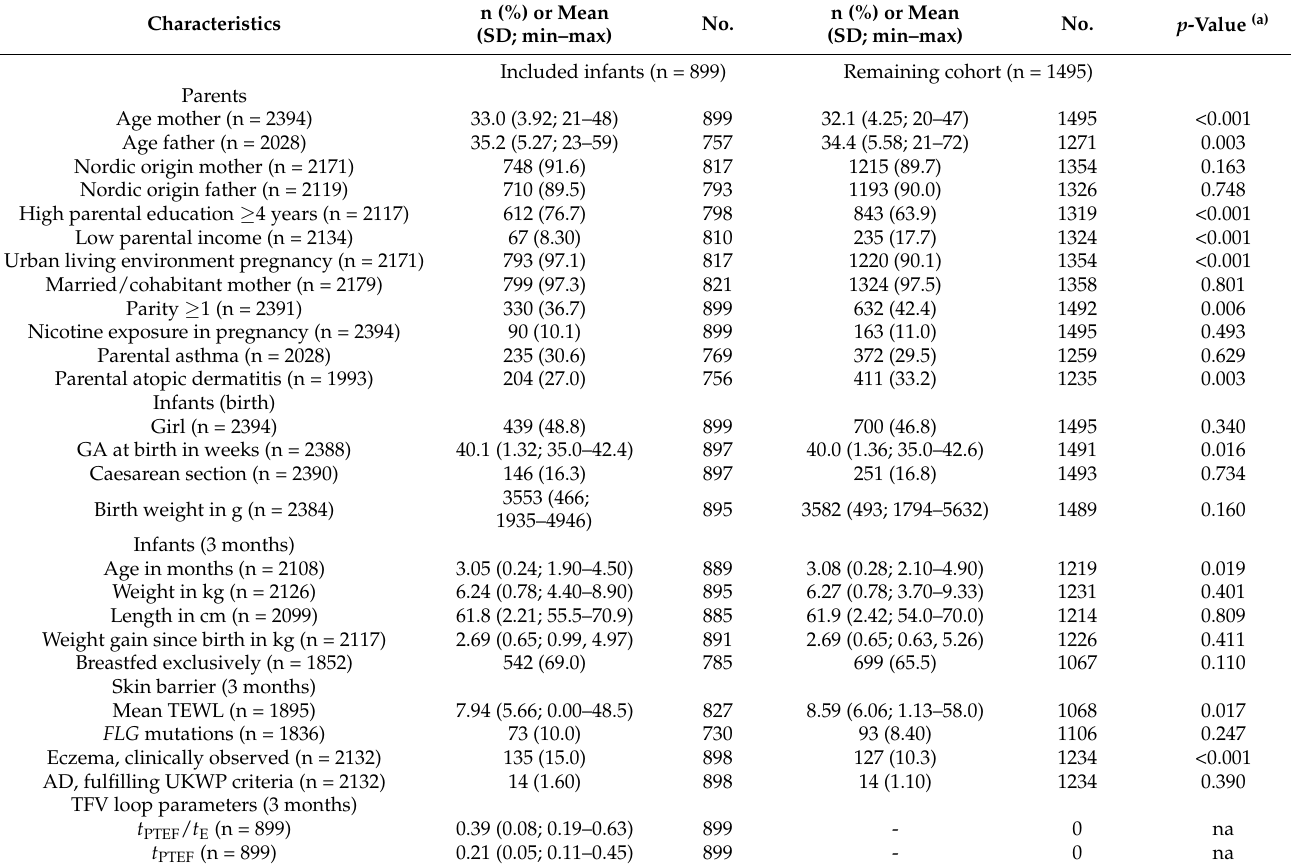
Table 1. Birth and background characteristics of the 899 included infants and the remaining cohort at three months of